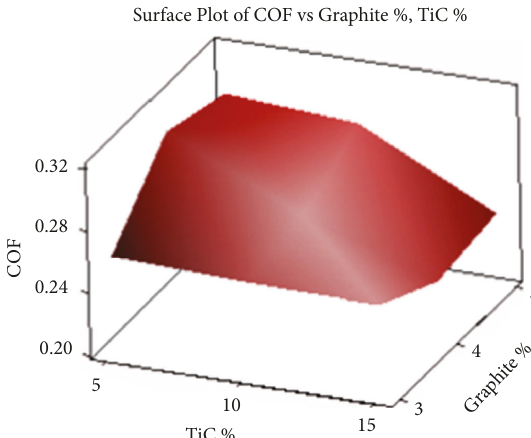
Figure 7: Surface plot graph for graphite % vs TiC to COF.